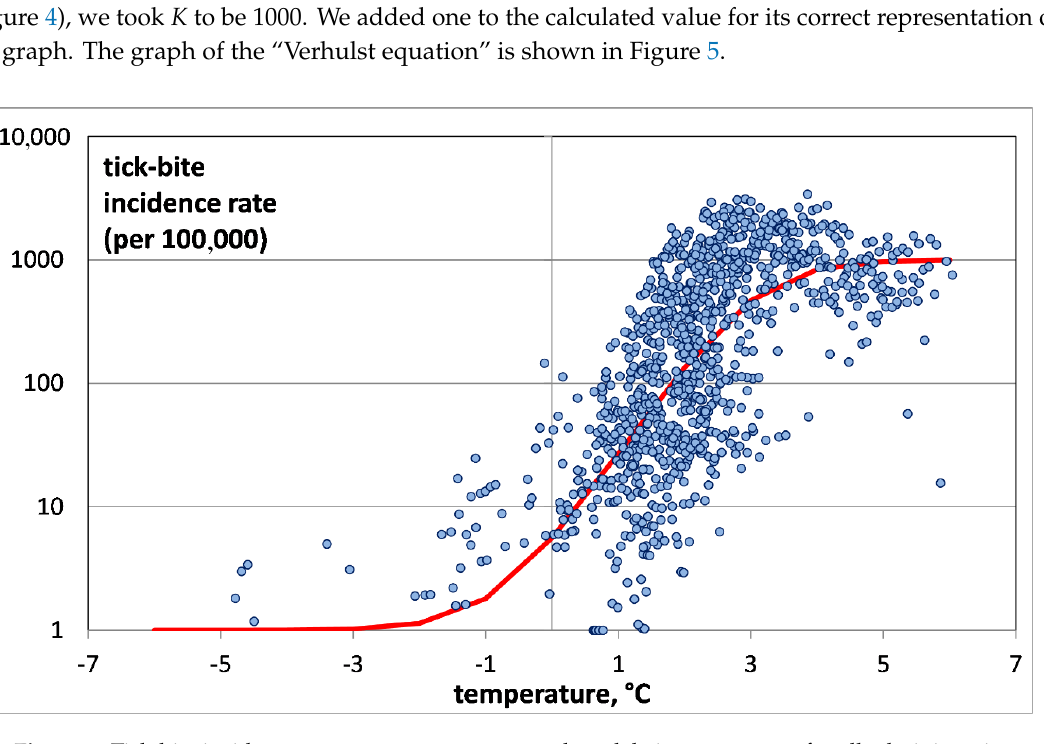
Figure 5. Tick-bite incidence rate versus average annual model air temperature for all administrative units of the Arkhangelsk Oblast, Karelia and Komi, and the “Verhulst equation” (shown in red).